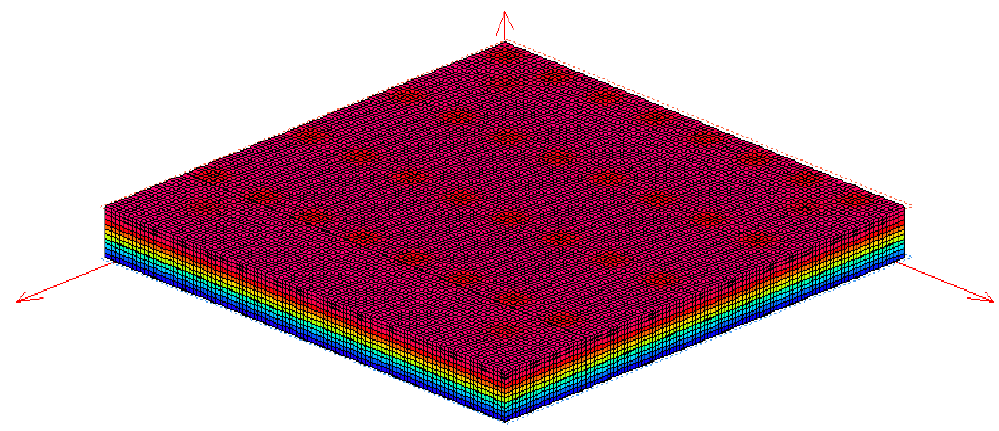
Figure 3. Isometric view of the corner zone of 1A assembly with 36 fasteners modeled in HEAT3, arranged according to standards.